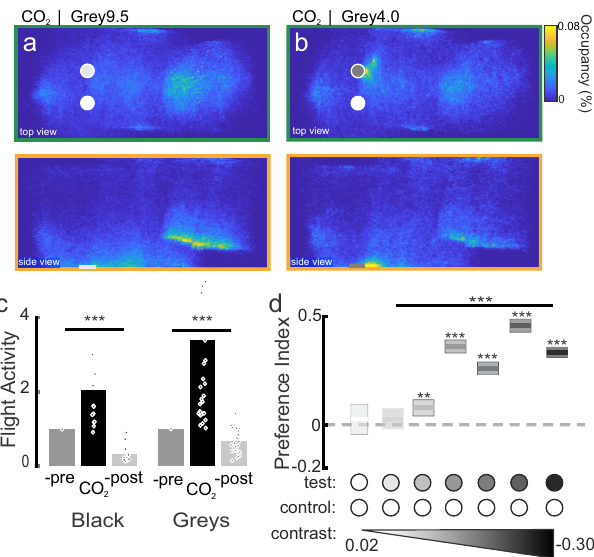
Fig. 5 The effect of achromatic contrast on mosquito attraction to visual objects. a Occupancy map of the distribution of female mosquitoes in the wind tunnel (top and side views) during CO 2 delivery in presence of a white and a light gray object (Weber Contrast: − 0.05). b As in a, except the gray object has a higher contrast ( − 0.23). c Relative fl ight activity between the different phases of the experiments (pre-, CO 2 and post-CO 2 ). Mosquitoes exhibited similar fl ight activities across all tested visual objects (Kruskal – Wallis test, df = 1, Chi-sq = 3.24, P = 0.07). d Mean preference indices for the test (gray, or black) vs. control object (white) with 95% con fi dence interval ( n = 12,764; 27,537; 37,085; 28,644; 36,050; 25,896; and 21,514 mosquito trajectories for the white, grey9.5, grey6.5, grey4.5, grey4.0, grey2.5, and black treatments, respectively). Object contrast had a signi fi cant effect on the attraction to the tested object (Kruskal – Wallis test: Preference Index~contrast tested object, df = 5, Chi-sq = 634.16, P <0.001). All gray objects were signi fi cantly more attractive than the control, white object (one-sample tw- tailed t -test, **: P <0.01, ***: P <0.001) except for the lightest gray object ( − 0.05), which was not more attractive (one-sample t -test: P = 0.33).